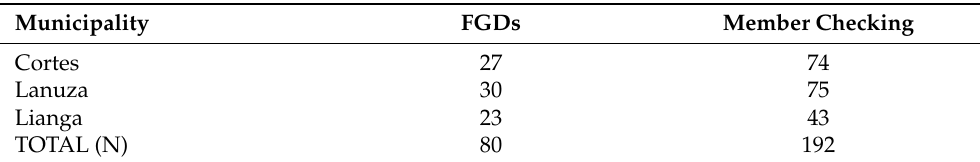
Table 1. Particiant from the different municipalities for focus group discussions and member checking in Surigao del